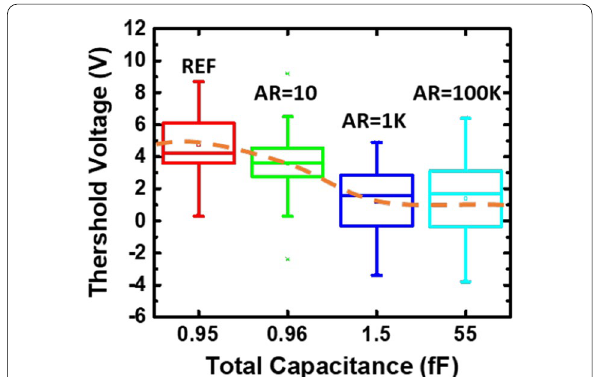
Fig. 2 Threshold voltage range of samples with different size of antenna, and the corresponding total capacitance on the